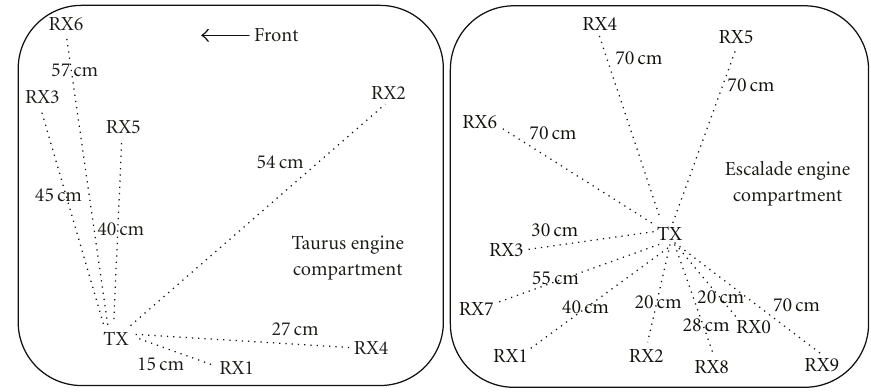
Figure 5: Antenna locations for the measurements inside the engine compartments.